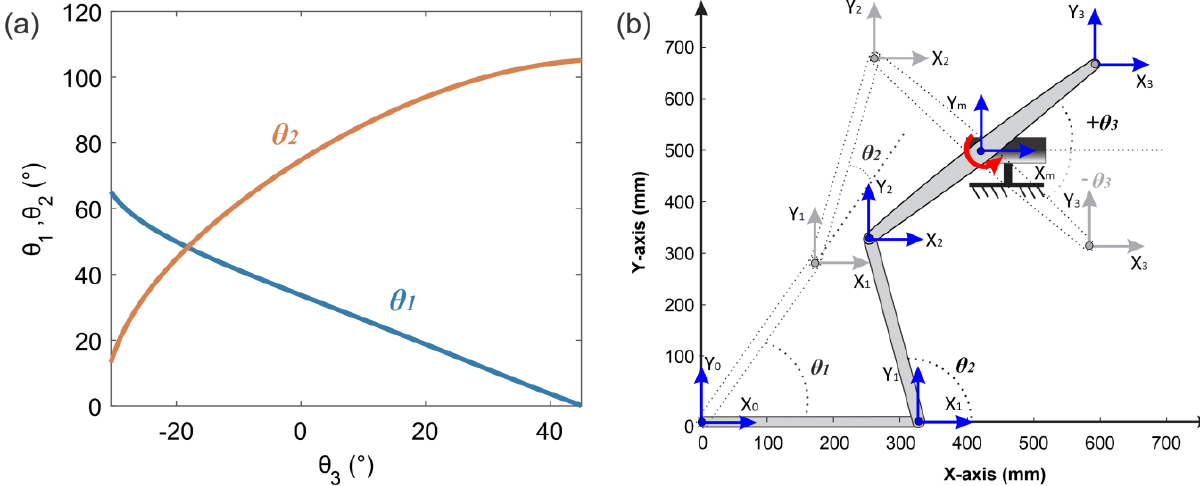
Figure 8. Kinematic ankle plantarflexion rehabilitation movement simulation. ( a ) angular positions θ 1 and θ 2 with respect to θ 3 , ( b ) two–dimensional graphical representation.